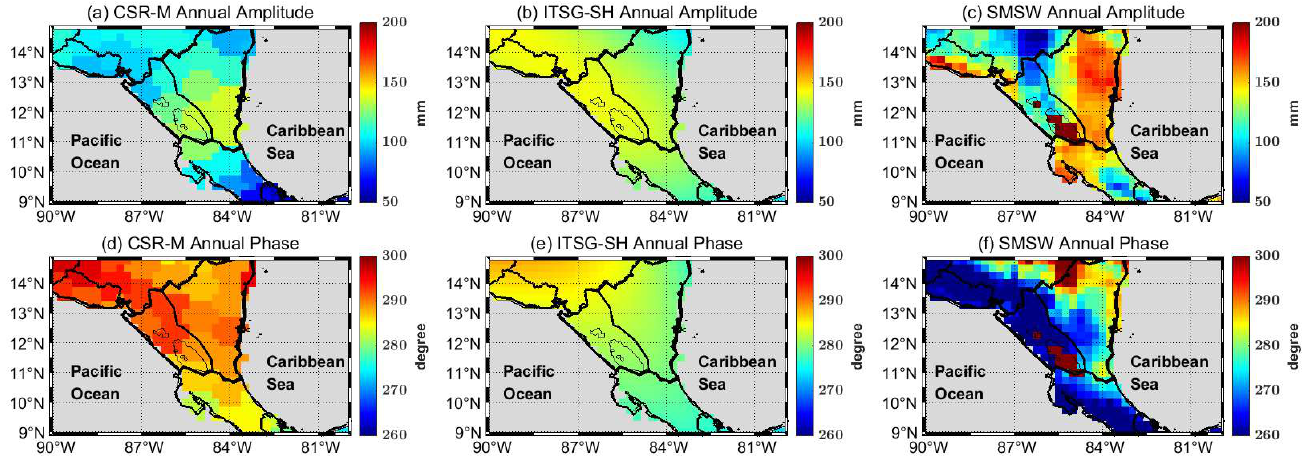
Figure 5. The spatial variations in annual amplitude values ( a – c ) and annual phase values ( d – f ) of TWSC (CSR-M, ITSG-SH, and SMSW) from April 2002 to April 2021.